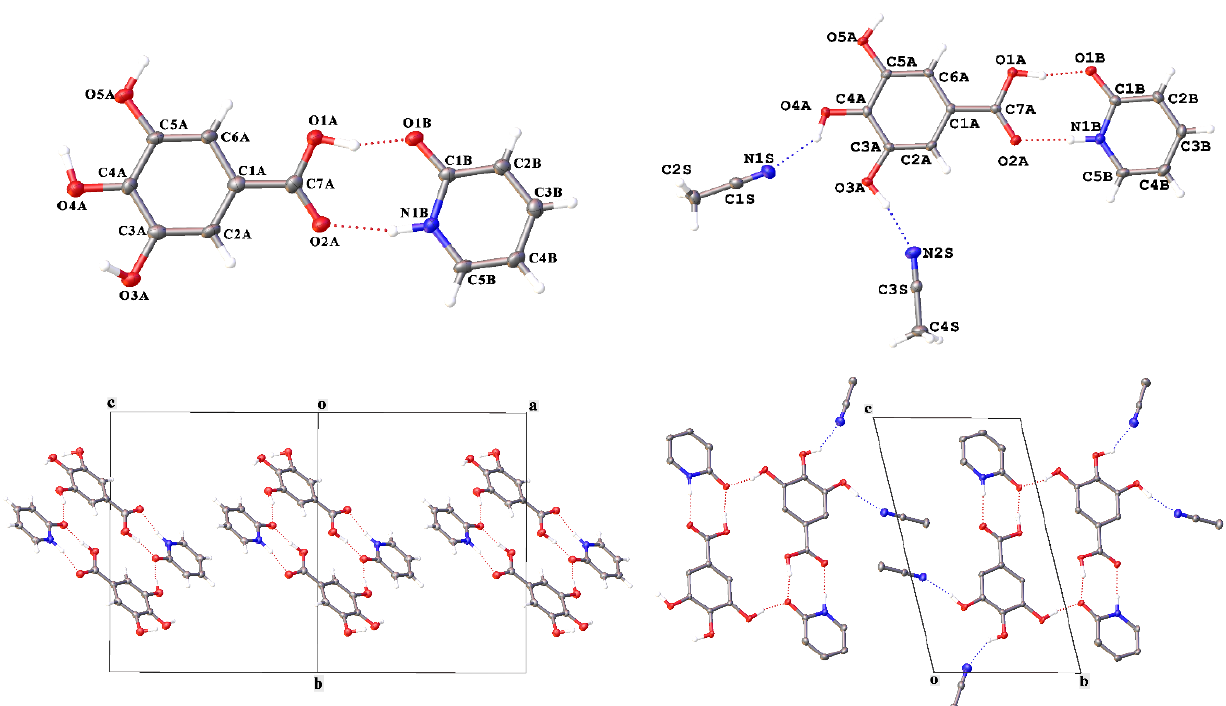
Figure 1. General views of 1 (top left) and 2 (top right) and fragments of the crystal packing in 1 (bottom left) and 2 (bottom right), illustrating the formation of hydrogen-bonded heterotetramers. Hereinafter, non-hydrogen atoms are shown as thermal ellipsoids ( p = 50%) and dashed lines stand for hydrogen bonds.